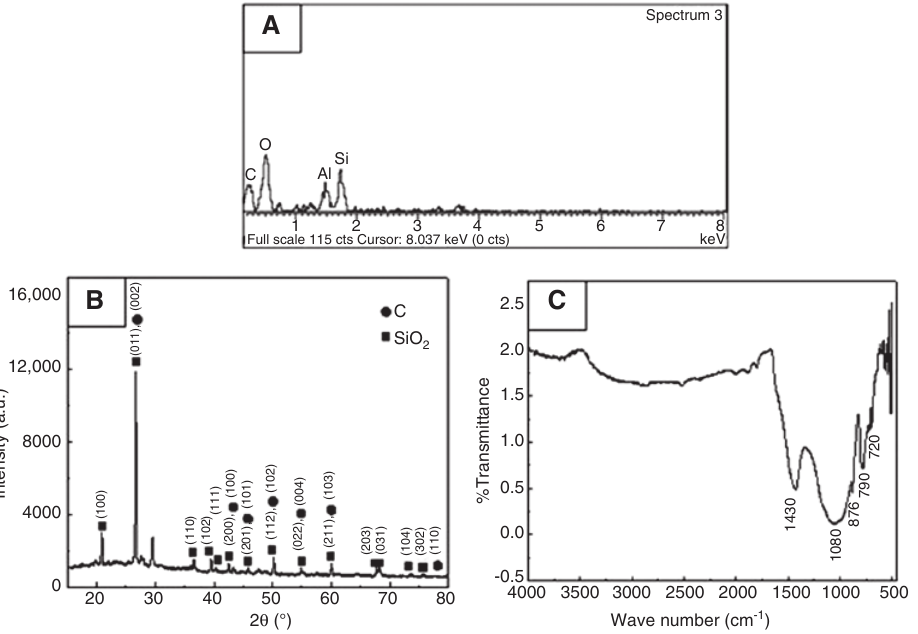
Figure 3: Spectra of nanocomposite. (A) Energy dispersive spectrum (EDS), (B) powder X-ray diffractogram (PXRD) and (C) Fourier transform infrared (FT-IR)